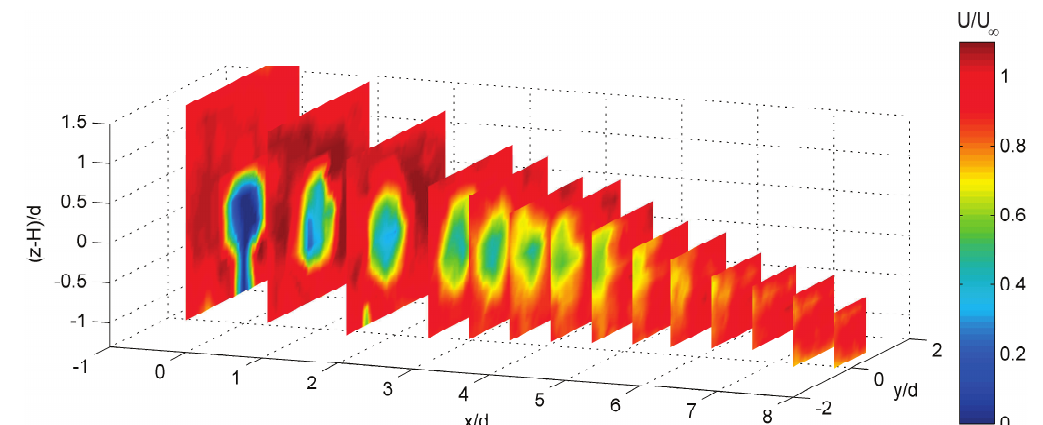
Figure 4. Volumetric scan of the wind turbine wake.